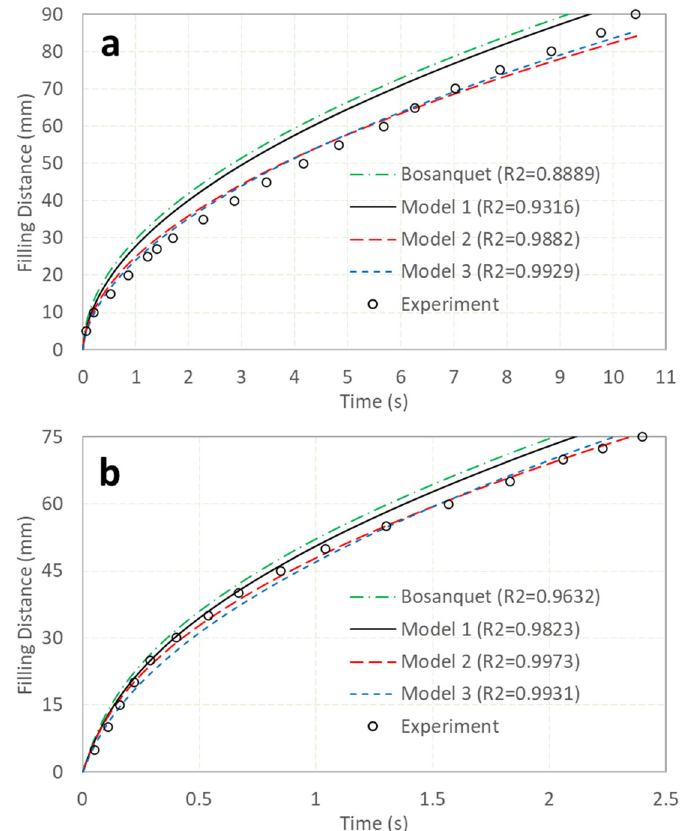
Figure 2. Experiment and simulation comparisons. The data from the experiment and the Bosanquet equation are from [11] directly; Model 1 considers gas in the tube only, Model 2 considers both the gas in the tube and the inner tube surface roughness, and Model 3 considers all the gas in the tube, the inner tube surface roughness, and the variable advancing contact angle. Here, ( a ) and ( b ) indicate tubes 0.5 and 1.15 mm in diameter, respectively.